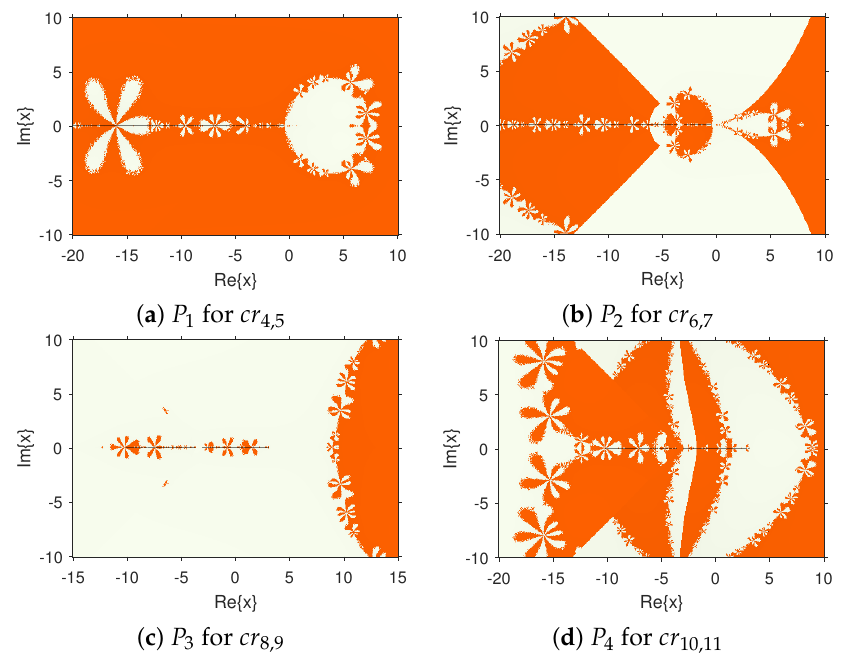
Figure 3. Parameter spaces P i , i =